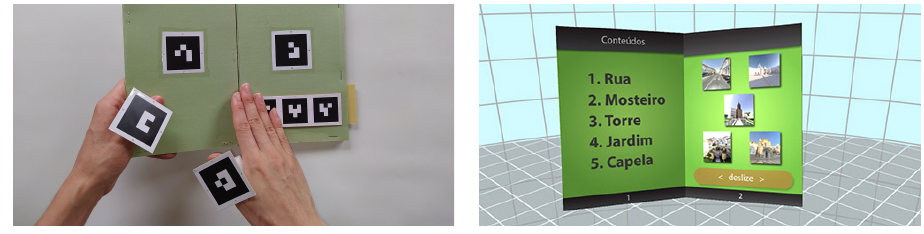
Figure 5. Content selection through the gesture slider.